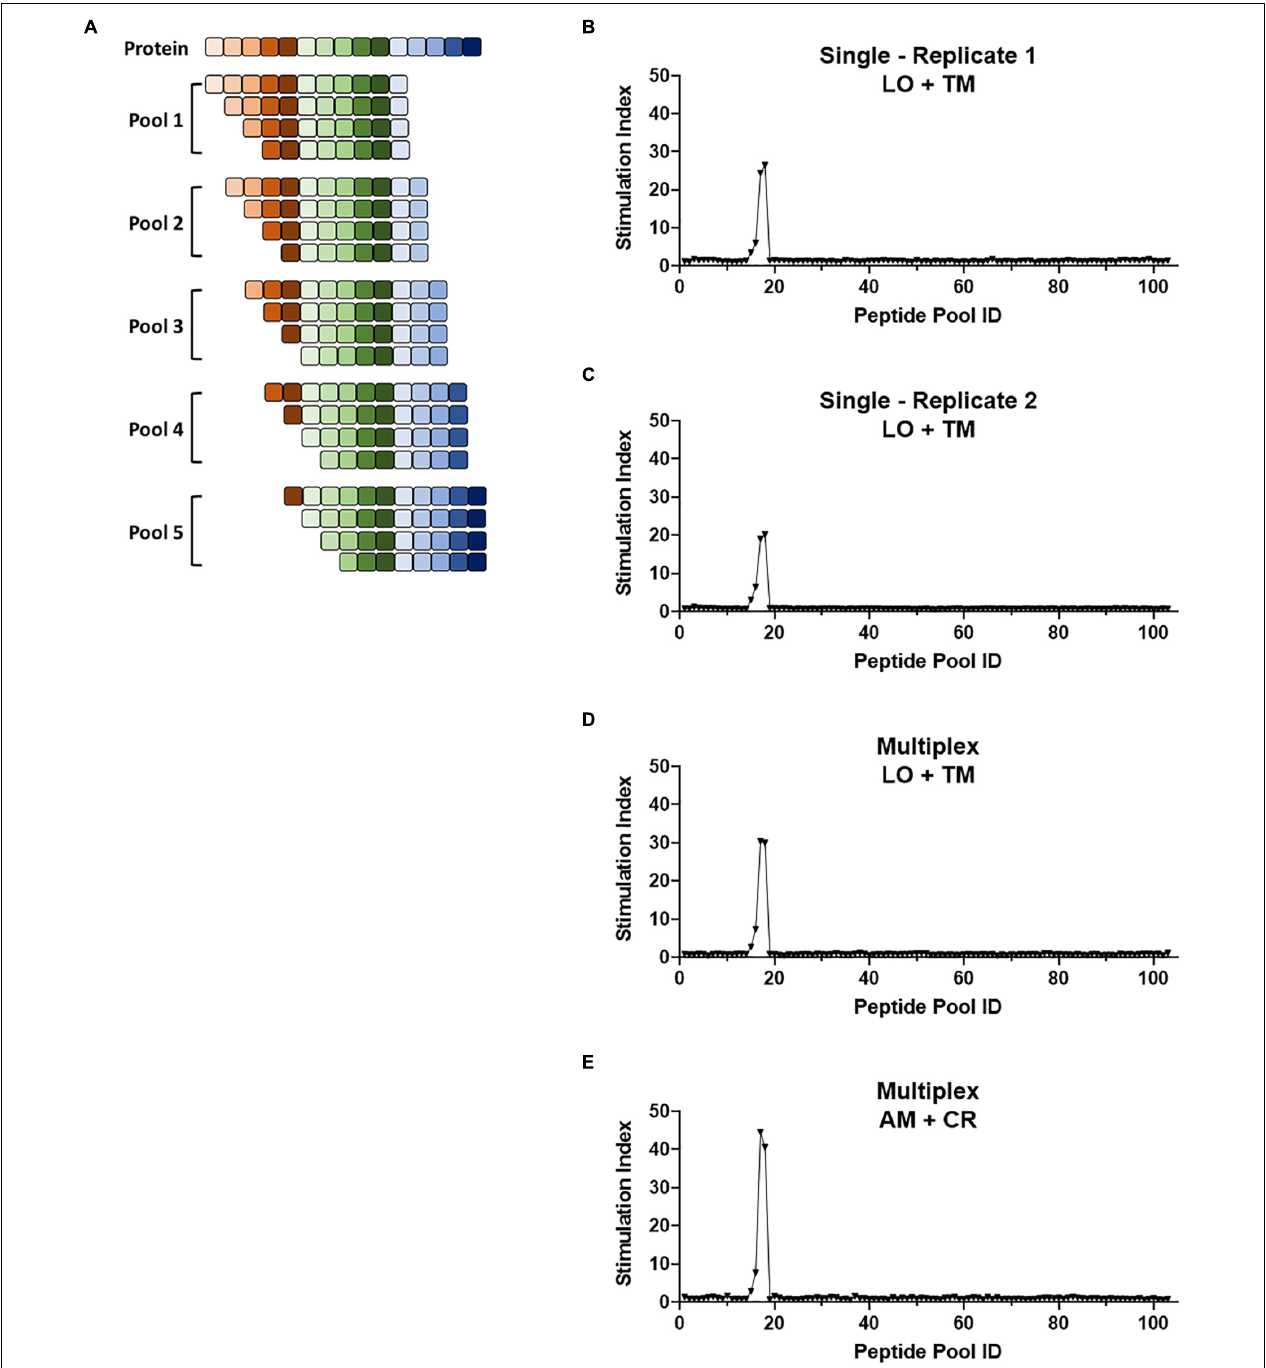
FIGURE 6 | Multiplex screening for a large panel of peptide libraries. (A) Schematic showing the breakdown of a protein of interest into pools of 8- to 11-mers such that each potential epitope of the peptide is represented in the peptide panel. Pools contain equimolar amounts of each truncated peptide. (B–E) 1E6 TCR T-hybridoma cells expressing LSSmOrange and tdTomato (B–D) or ametrine and E2-Crimson (E) were co-cultured with 103 truncated peptide pools generated from preproinsulin and HLA-A2 K562 cells in the absence [ (B,C) , single test] or presence [ (D,E) , multiplex test] of T-hybridomas expressing irrelevant TCRs with the other seven fluorochrome combinations. Stimulation indexes of 1E6 TCR T-hybridomas in response to the peptide stimulation were calculated as described in Figure 5 based on frequency of ZsGreen-1-positive 1E6 TCR T-hybridoma cells determined by flow cytometry using a gating strategy shown in Supplementary Figure S2 . Results from two independent experiments testing a single T-hybridoma cell line individually are shown in (B,C) . In all cell culture conditions testing 1E6 TCR T-hybridoma cell lines expressing different fluorescence identifiers, T-hybridomas responded to peptide pools 15–18 with a peak at 17 and 18. These pools contain the cognate peptide PPI:15-23 and